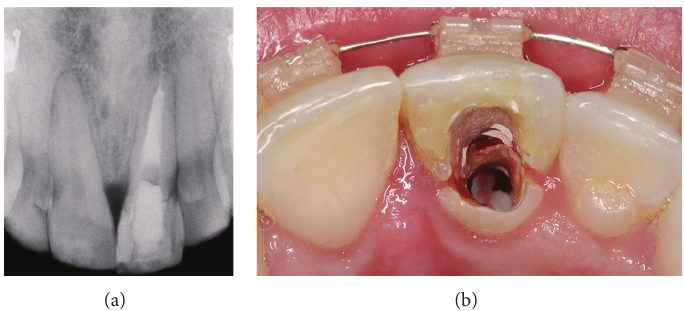
Figure 4: Radiographic and clinical images showing the endodontic retreatment, with the installation of an intracanal pin and temporary crown